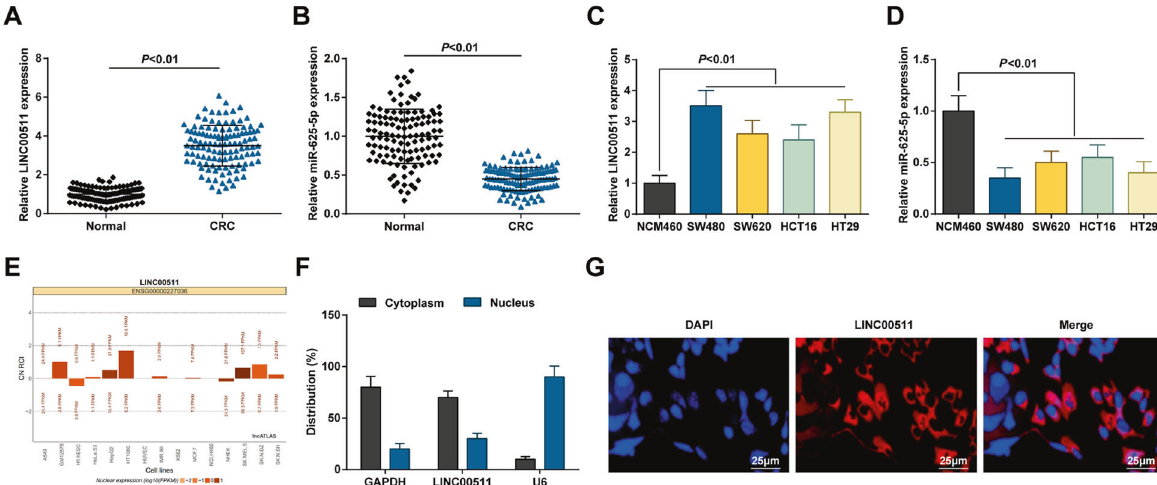
Fig. 1 LINC00511 attains a high level while miR-625-5p a low level in CC. A RT-qPCR detected LINC00511 expression in CC tumor tissues and normal tissues ( n = 120); B RT-qPCR detected miR-625-5p expression in CC tumor tissues and normal tissues ( n = 120); C RT-qPCR detected LINC00511 expression in CC cell lines and normal epithelial cells; D RT-qPCR detected miR-625-5p expression in CC cell lines and normal epithelial cells; E Bioinformatics website predicted the subcellular localization of LINC00511; F subcellular separation assay detected subcellular localization of LINC00511; G FISH assay detected subcellular localization of LINC00511; the measurement data are expressed as mean ± standard deviation. N = 3.